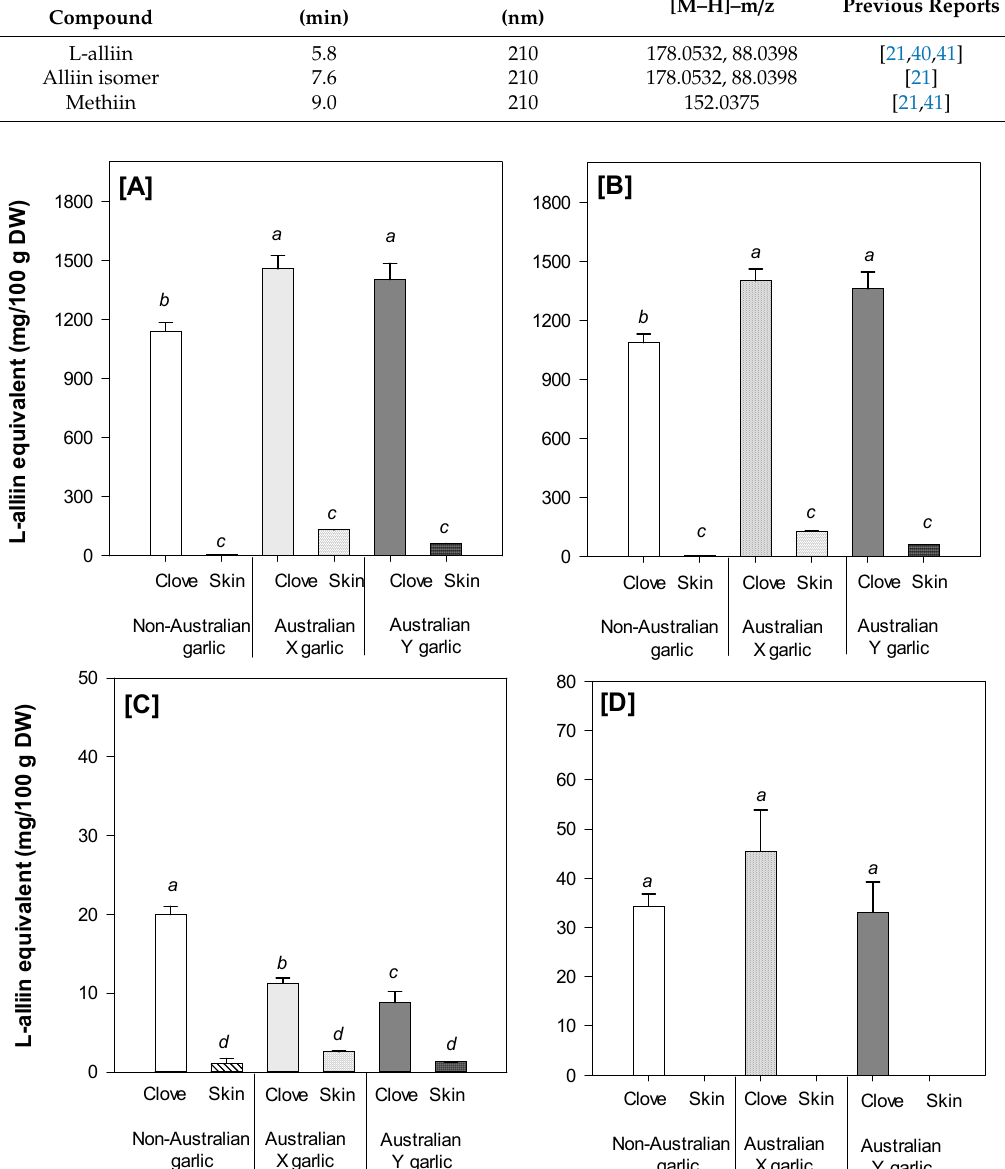
Figure 2. Total amount of organosulfur compounds ( A ) and individual organosulfur compounds, including L-alliin ( B ), alliin isomer ( C ), and methiin ( D ) in di ff erent garlic samples. Data present mean ± SD ( n = 3). Di ff erent letters in the same figure indicate significant di ff erences at α =